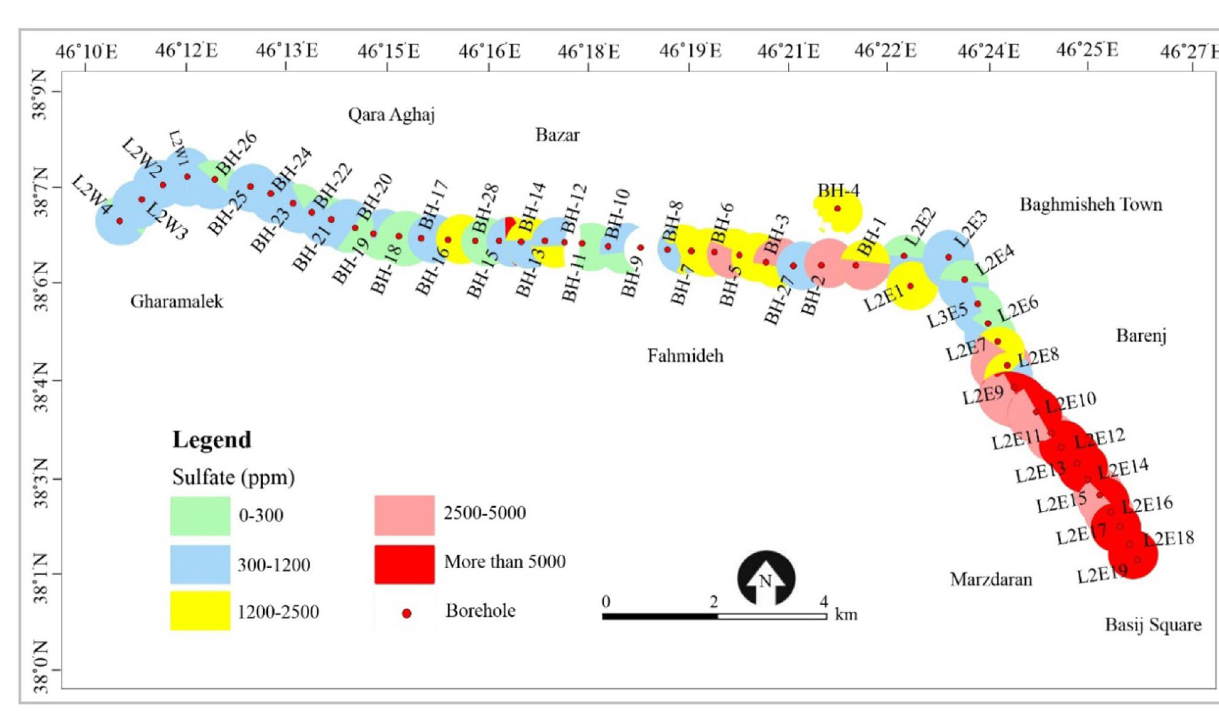
Fig. 10 Zoning of boreholes of line 2 of Tabriz Metro in terms of the amount of soluble sulfate